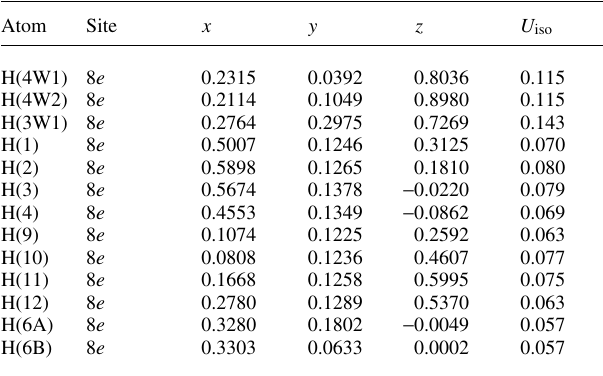
Table 2. Atomic coordinates and displacement parameters (in Å 2 ) . Table 1. Data collection and